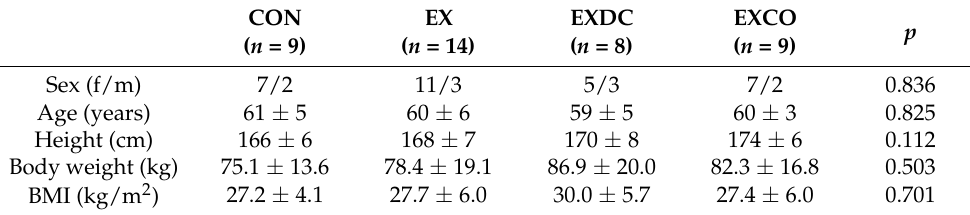
Table 1. Baseline characteristics of all